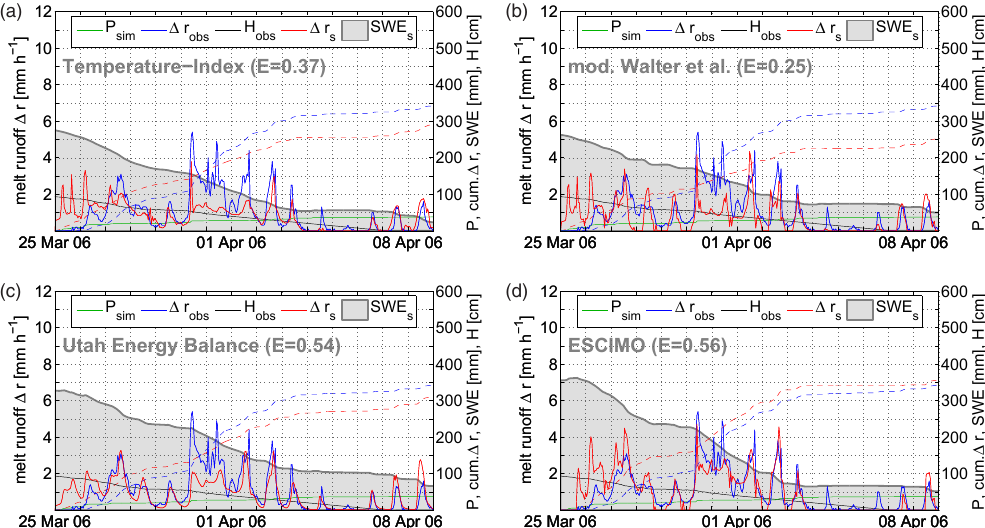
Figure 10. Snowmelt simulations at the point scale using downscaled meteorological time series for the winter season 2005–2006. Statistics refer to the period 25 March–9 April 2006: (a) temperature-index approach, (b) modified Walter et al. (2005) approach, (c) Utah Energy Balance model, and (d) ESCIMO. For every simulation run, downscaled precipitation depth ( P sim ), observed runoff ( (cid:49)r obs , blue line), observed runoff depth (blue dashed line), observed snow depth ( H obs ), simulated runoff ( (cid:49)r s , red line), simulated runoff depth (red dashed line), and simulated snow water equivalent (SWE s ) are plotted. Model efficiencies E are also given for each run.